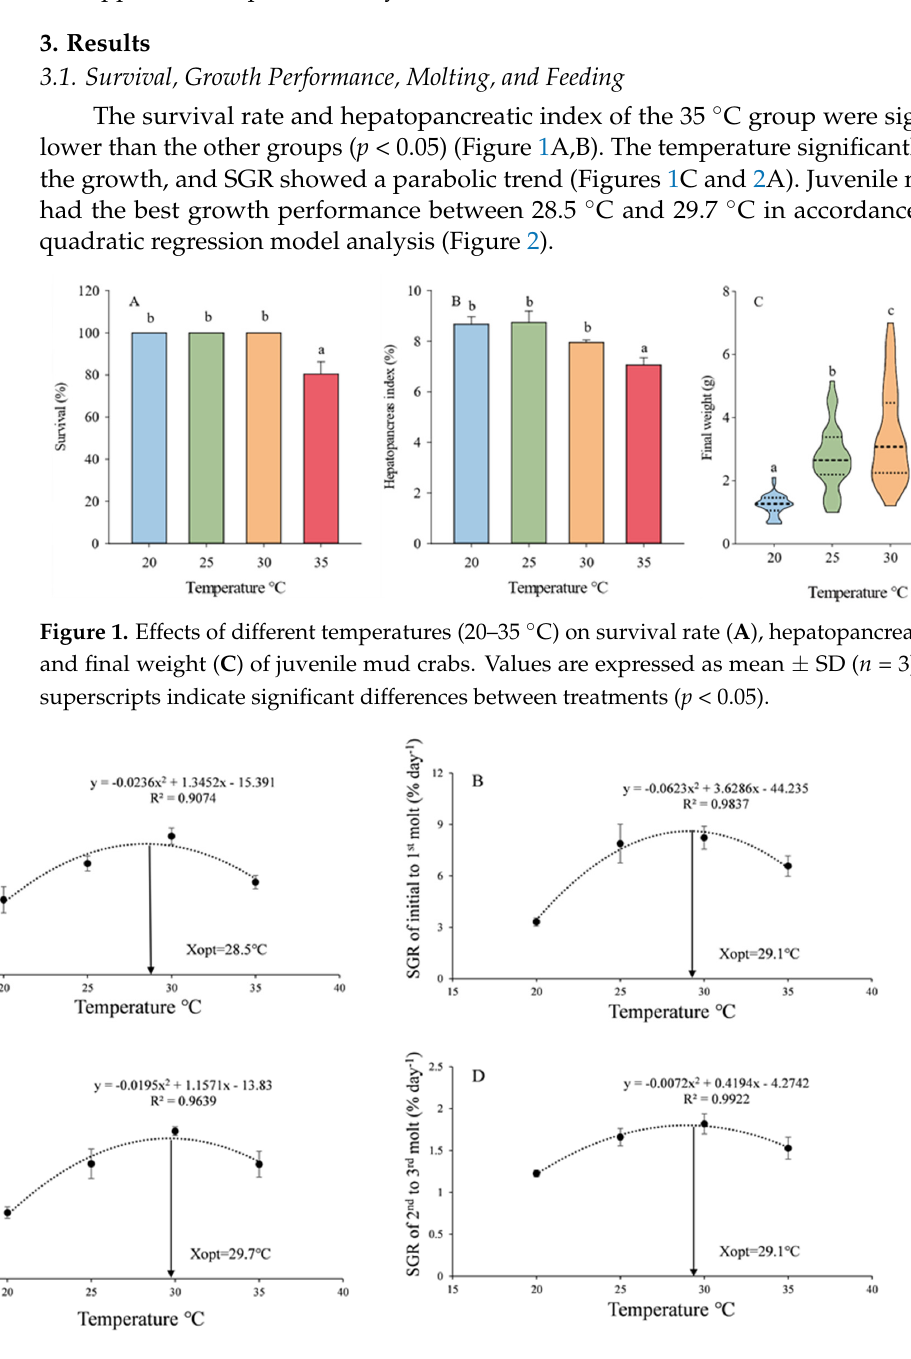
Figure 3. Effects of different temperatures (20–35 °C) on the molt frequency and molt increment of juvenile mud crabs. Values are expressed as mean ± SD ( n = 3). Different superscripts indicate sig- nificant differences between treatments ( p < 0.05).